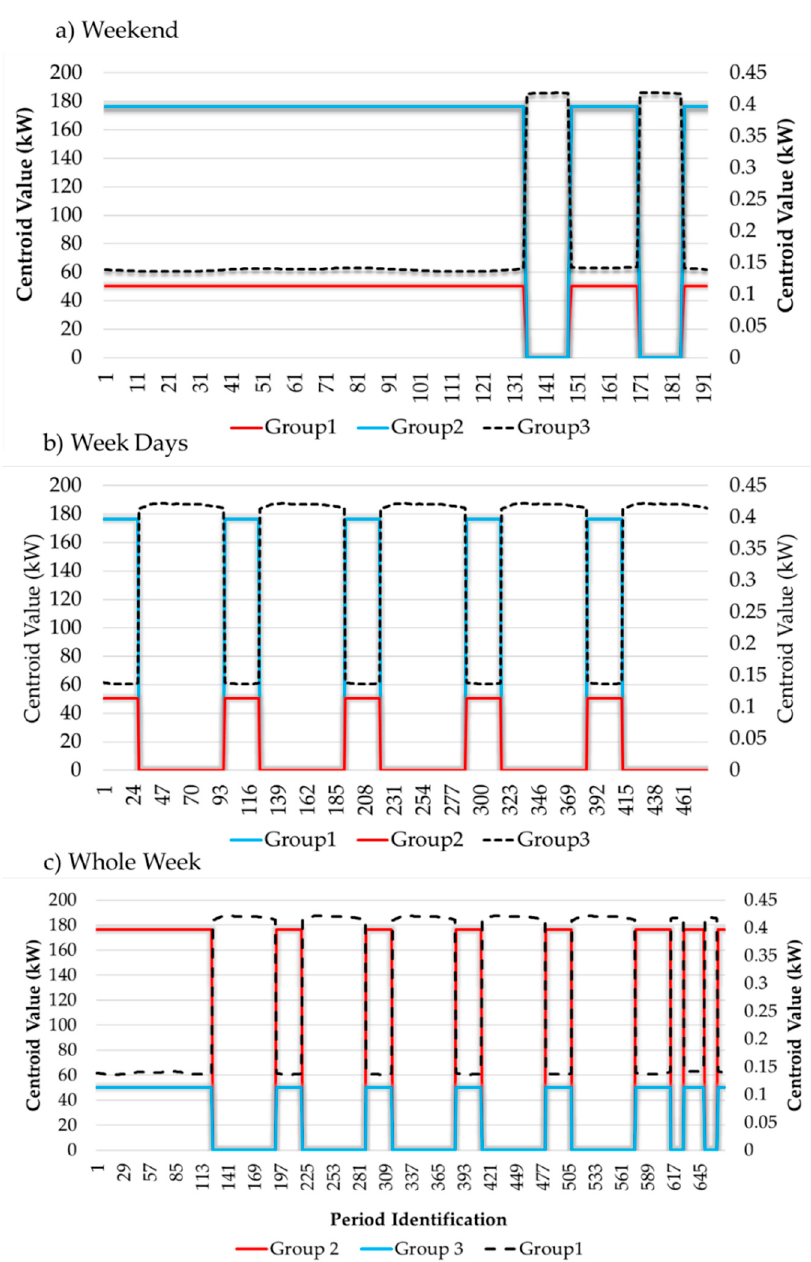
Figure 9. Comparison between different scenarios, for k=3.